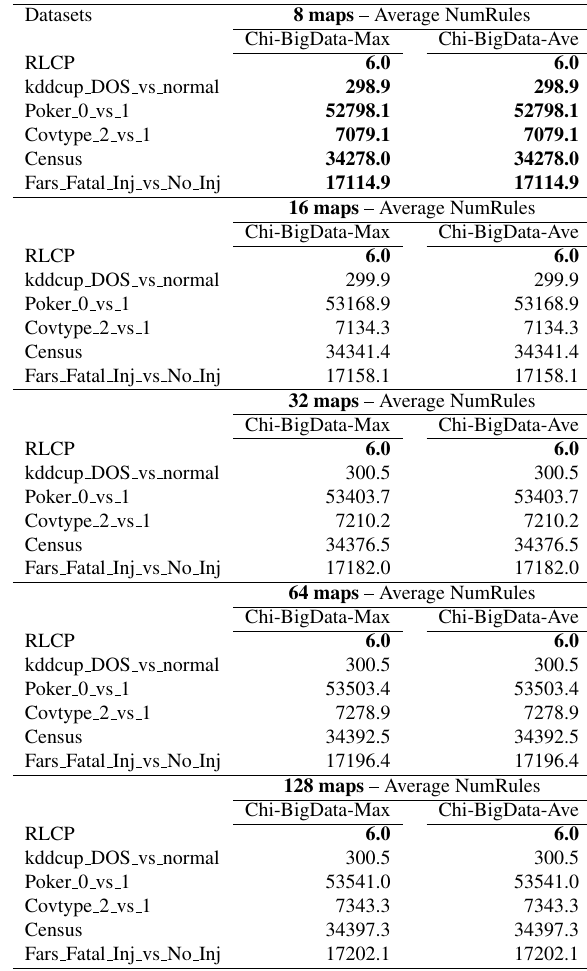
Table 9. Average number of rules generated for the Chi- FRBCS-BigData versions using 8, 16, 32, 64 and 128